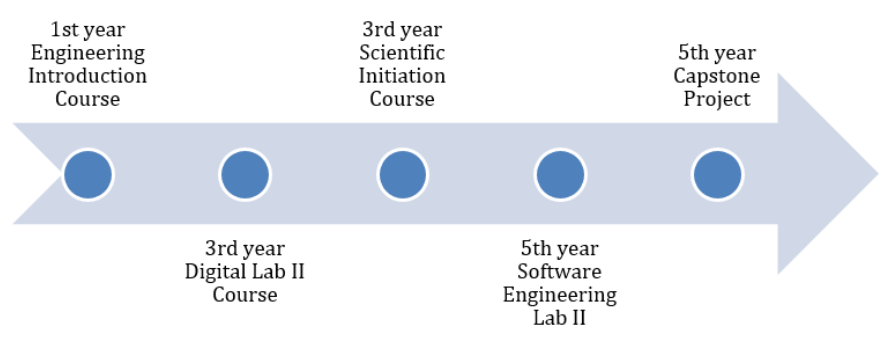
Figure 1. PjBL initiatives during social distancing for Computer Engineering in